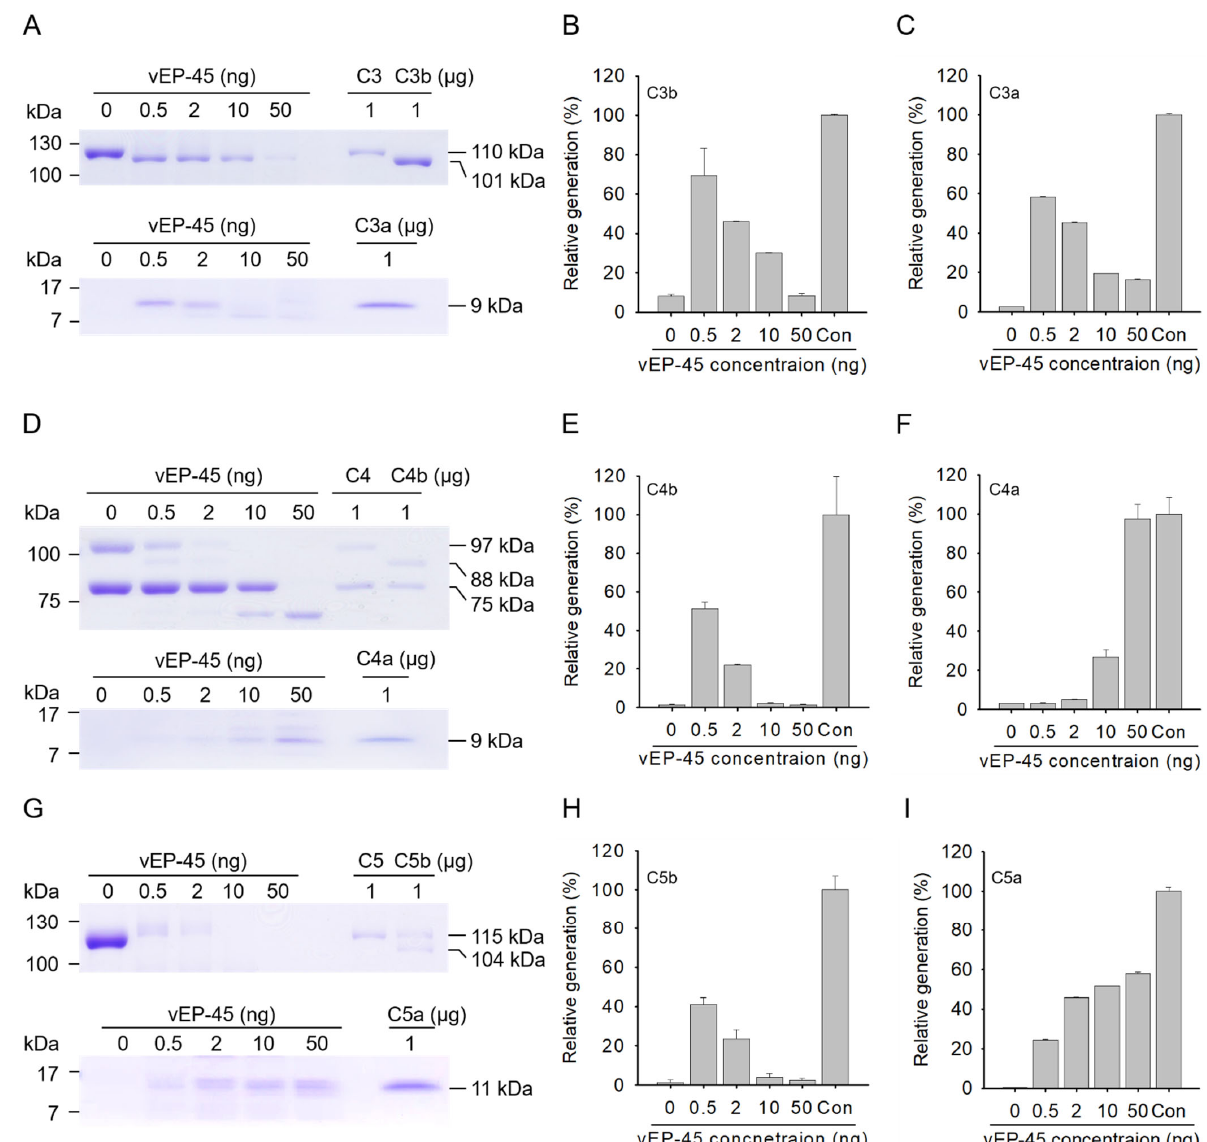
Figure 1. Cleavage of human complement proteins (C3, C4, and C5) by vEP ‐ 45 as determined by SDS ‐ PAGE. ( A , D , G ) Human complement protein C3, C4, or C5 (each 5 μ g) was incubated with vEP ‐ 45 (0.5, 2, 10, or 50 ng) for 10 min at 37 °C. Proteins from each sample were separated via SDS ‐ PAGE and stained with Coomassie brilliant blue. The histograms show the production of ( B ) C3b α′ chain, ( C ) C3a, ( E ) C4b α′ chain, ( F ) C4a, ( H ) C5b α′ chain, and ( I ) C5a upon treatment with different concentrations of vEP ‐ 45, in which the values obtained using the control (Con; only C3b, C3a, C4b, C4a, C5b, and C5a) were considered as 100%. The uncropped SDS ‐ polyacrylamide gel images can be found in Figure S1.